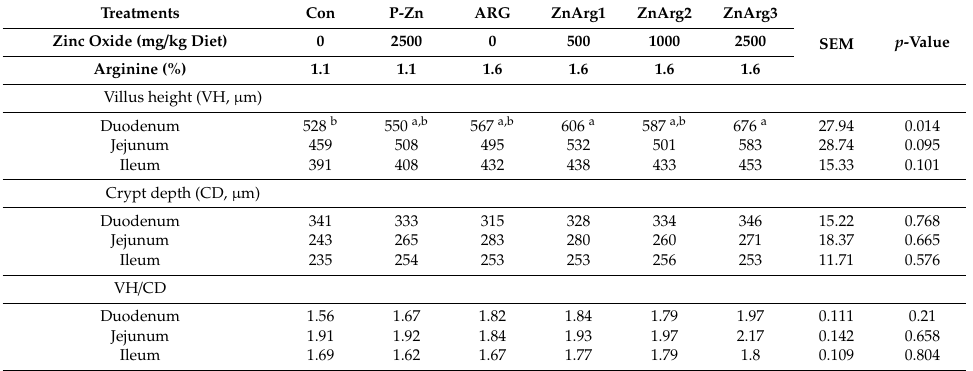
Table 5. E ff ect of dietary zinc and arginine on intestinal morphology of weanling piglets exposed to high temperature.